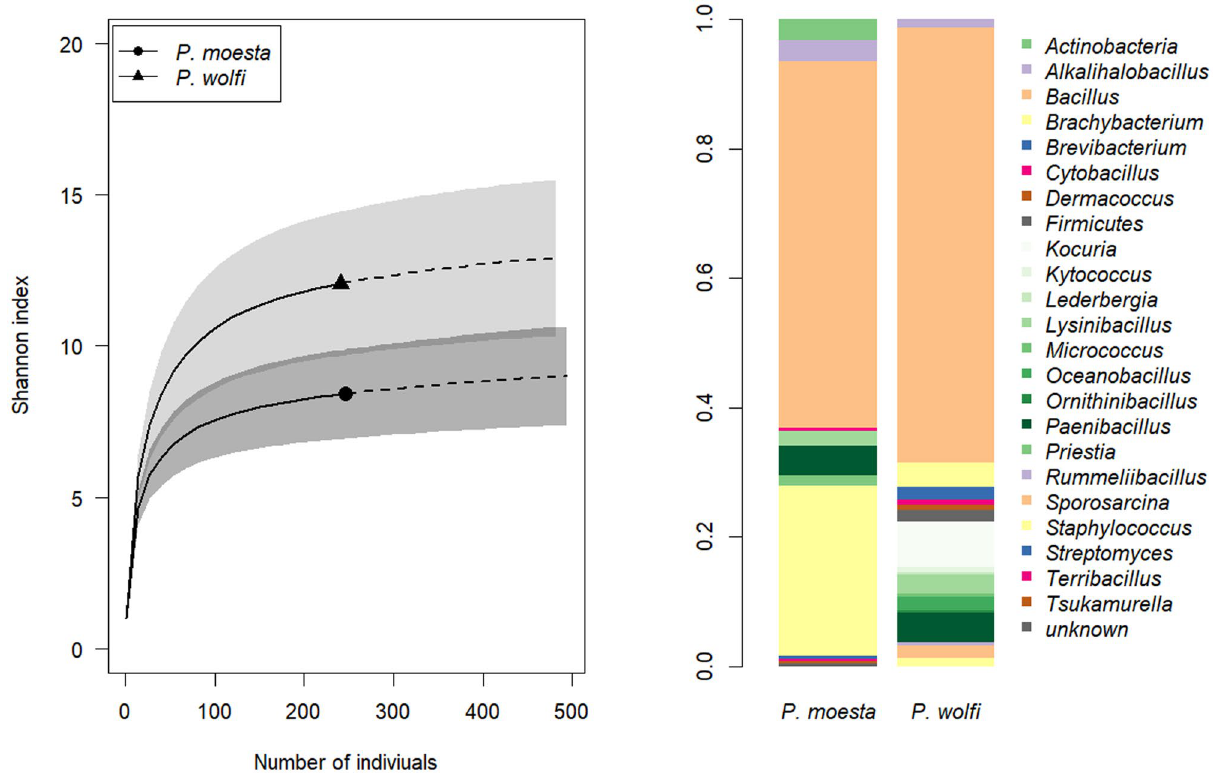
Figure 2. Species diversity and genus abundance of bacteria isolated from ant cadavers infected with Ophiocordyceps unilateralis sensu lato estimated by using R software with the “iNEXT” package (https:// www.r- proje ct.